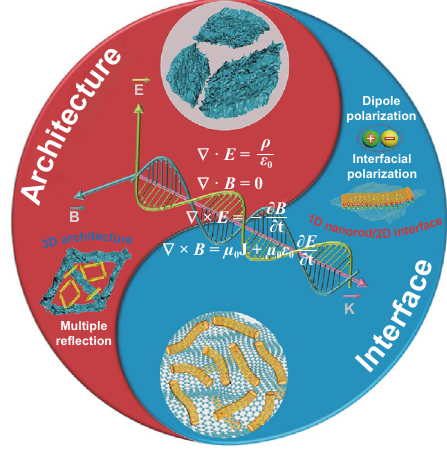
Fig. 7 Schematic illustration for the microwave absorption mecha- nism of VS 4 /rGO